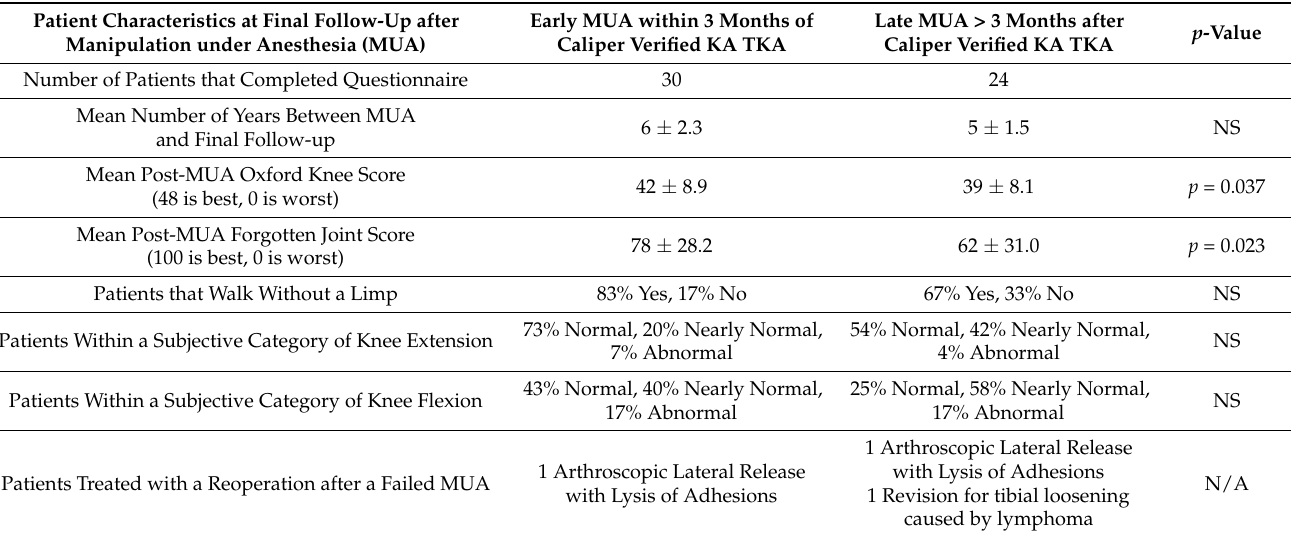
Table 3. Patient Characteristics at Final Follow-up After MUA for Patients Treated with an Early and Late